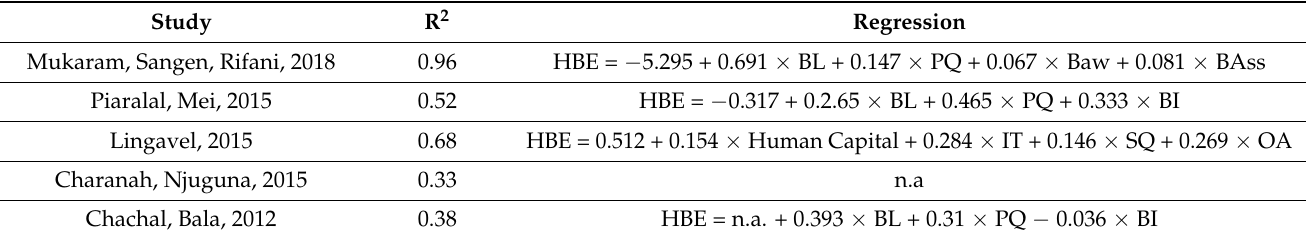
Table 4. Regression analysis for traditional HBE